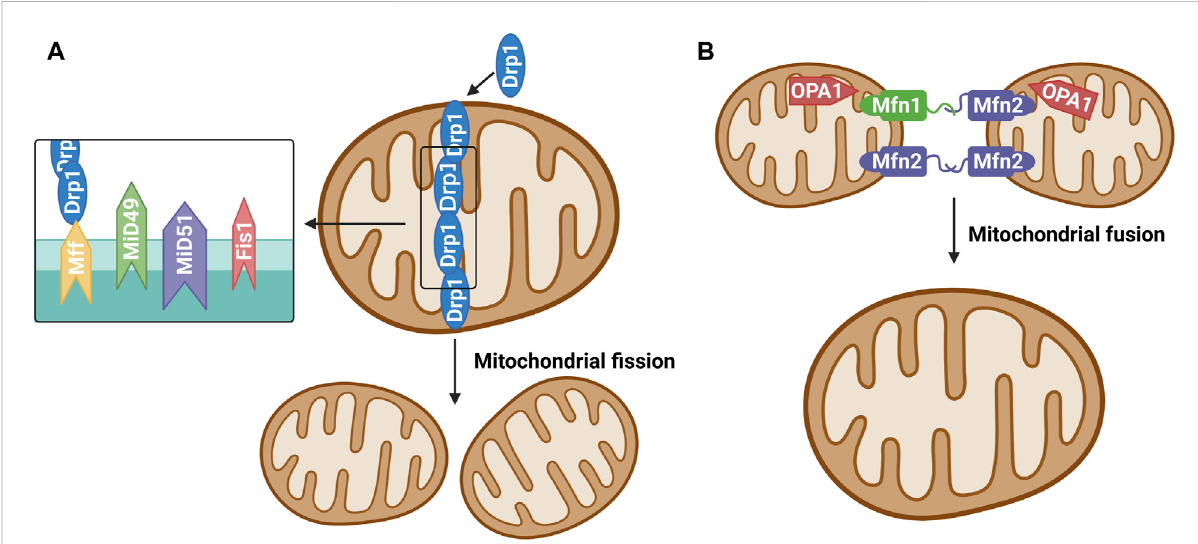
FIGURE 1 (A) Mitochondrial fi ssion. The protein that regulates mitochondrial fi ssion is mainly Drp1, which is generally localized in the cytoplasm under physiological conditions. Various stimulators result in recruitment and oligomerization of Drp1 to mitochondria by binding its receptors Mff, Fis1, MiD49andMiD51,andtheninducemitochondrial fi ssion. (B) Mitochondrialfusion.Mitochondrialfusionproteinsincludemainlymitochondrialfusion protein 1 (Mitofusin1, Mfn1), mitochondrial fusion protein 2 (Mitofusin 2, Mfn2) and optic atrophy one protein (OPA1). Mfn1 and Mfn2 are widely expressed in the mitochondrial outer membrane and mediate the fusion of outer membrane of mitochondria. OPA1 is mainly involved in the mitochondrial inner membrane fusion